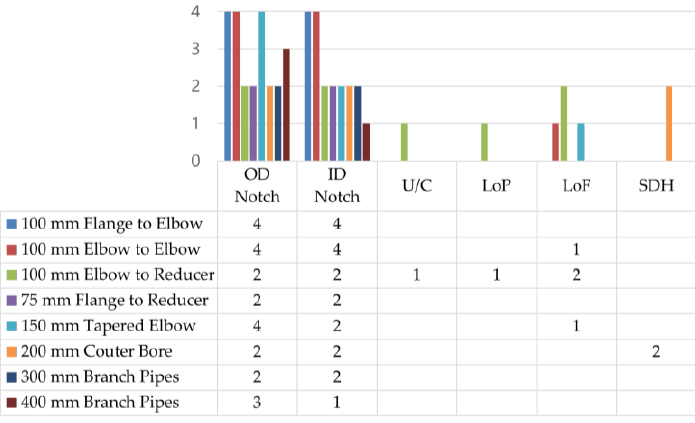
Figure 18. Distribution of flaws according to each specimen.